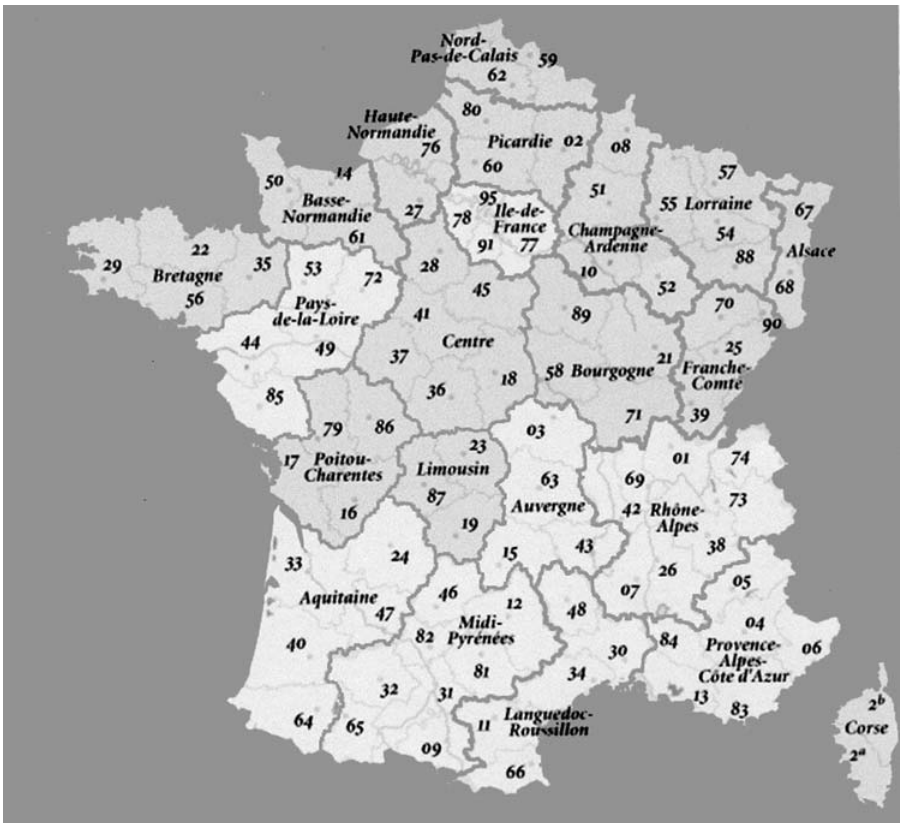
Figure 1. Regions of France involved in the medical and herpetological survey of Viperaaspisenvenomation. The regions and departments (indicated by numbers) where the medical and herpetological surveys were conducted are shown in light grey.